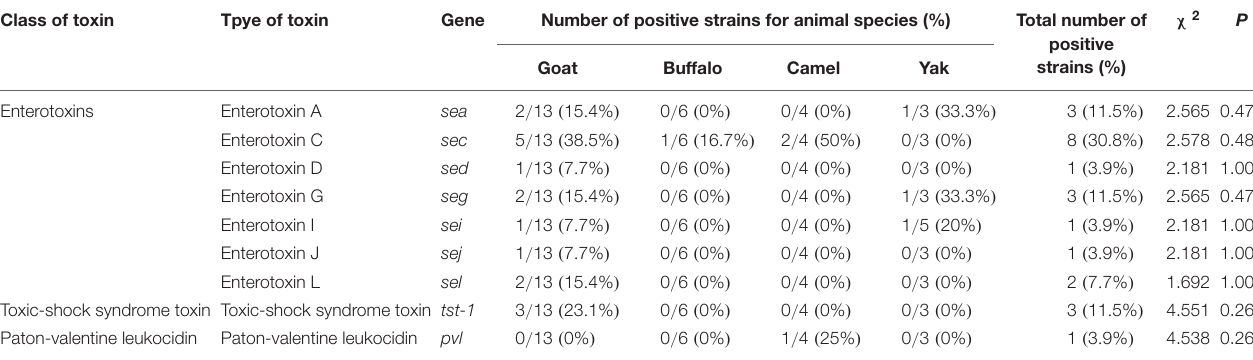
TABLE 4 | Virulence genes identified in Staphylococcus aureus strains isolated from different raw milk samples ( n = 26). Class of toxin Tpye of toxin Gene Number of positive strains for animal species (%) Total number of